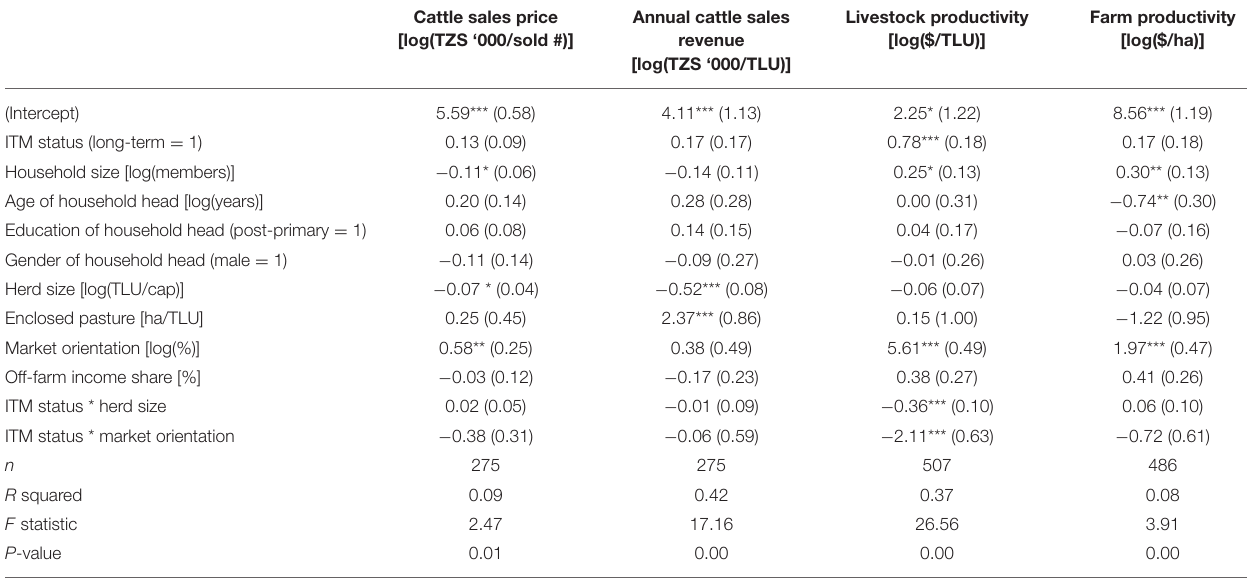
TABLE 6 | ITM vaccination and indicators of farm